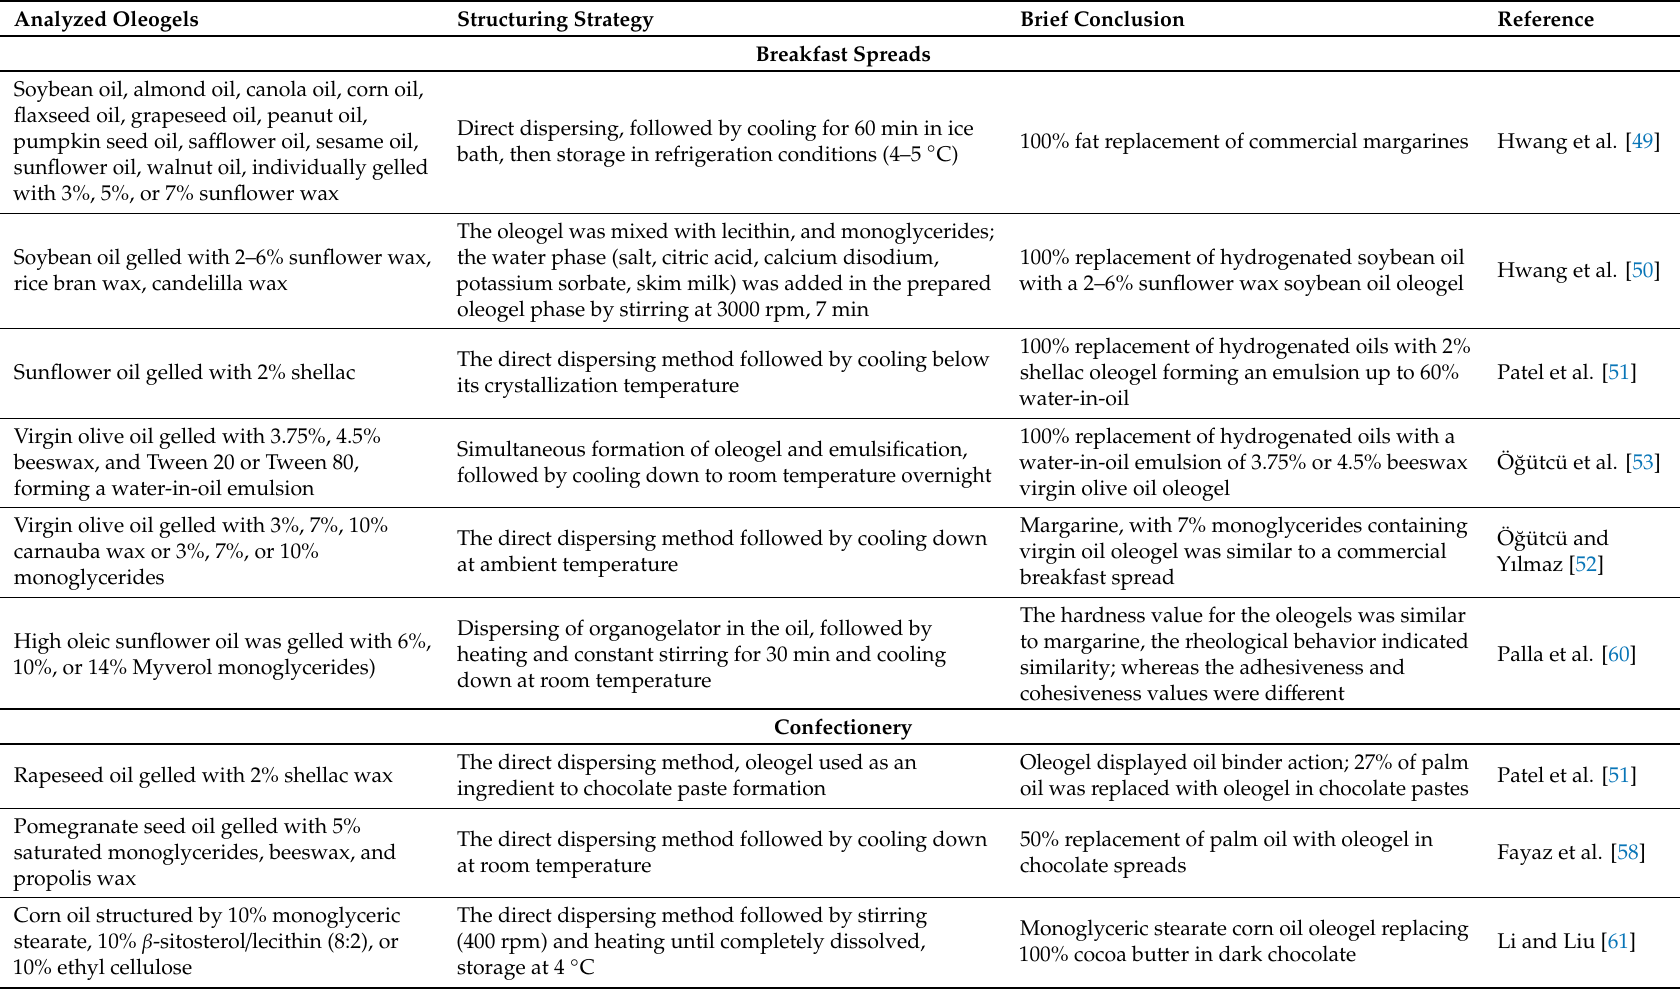
Table 2. Overview of oleogels used in food: short description, structuring strategy, and a brief